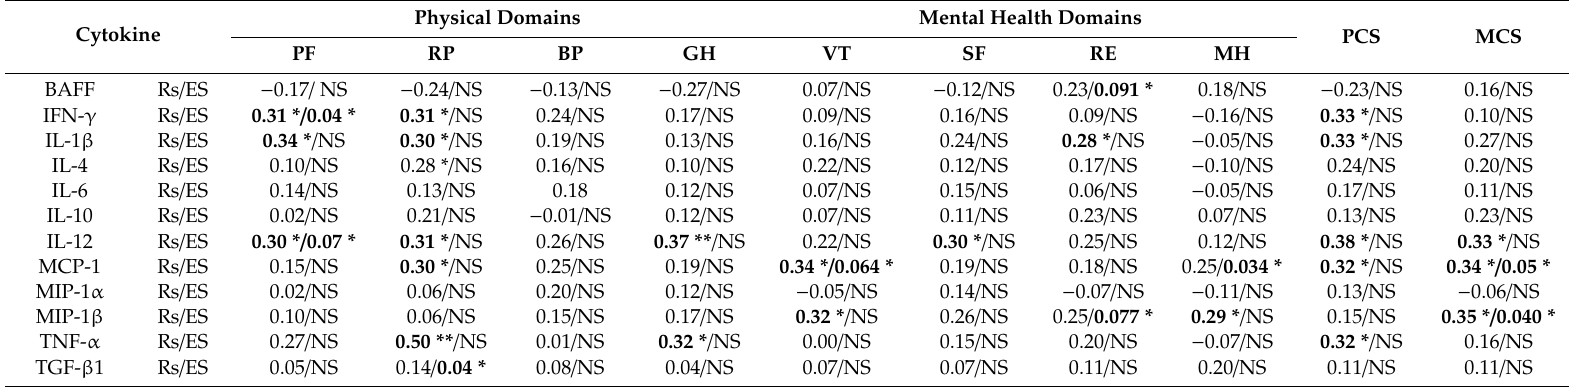
Table 3. Spearman rank correlation and linear regression coe ffi cients for the overall strength (Rs) and e ff ect size (ES) of the relation between the inflammatory cytokine levels (pg / ml) and health related quality of life, quantified with the Short Form 36 domain and summary